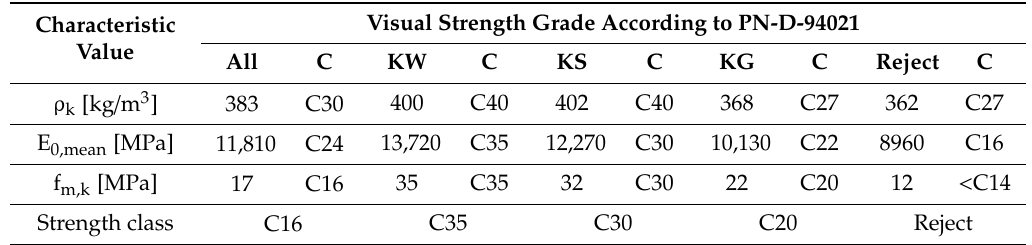
Table 3. Characteristic values of physico-mechanical parameters for di ff erent quality classes of